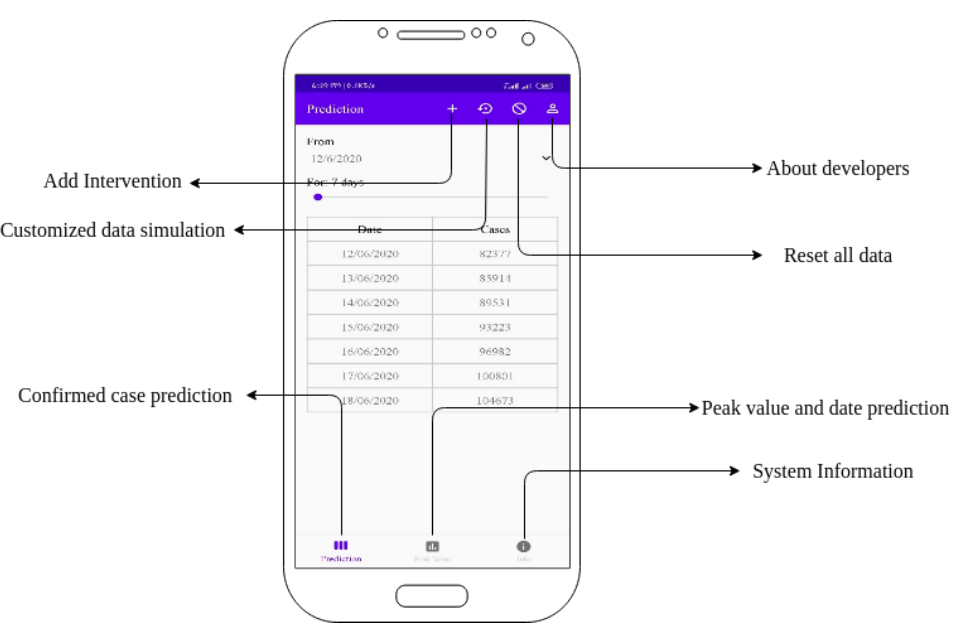
Figure 4. Home page of the mobile application.